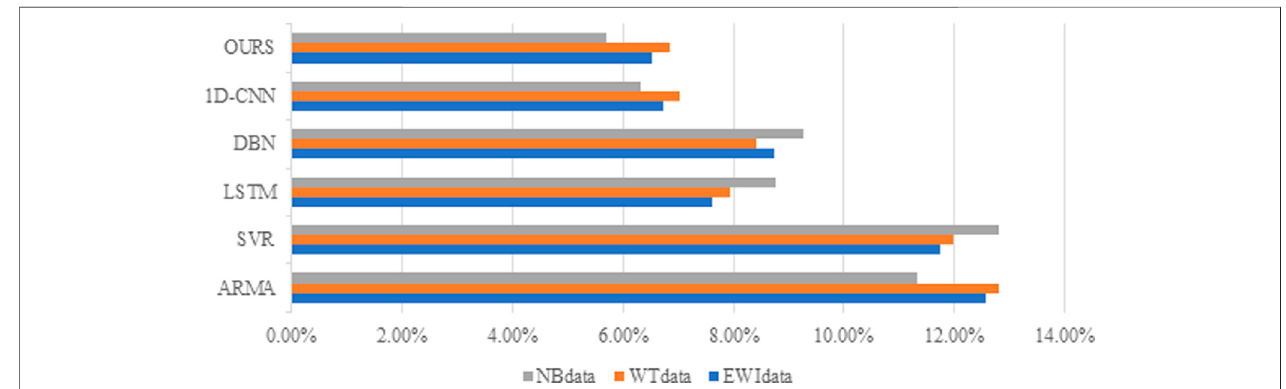
FIGURE 14 | Comparison of the average mean absolute percentage error (MAPE) of the different prediction models on different datasets.